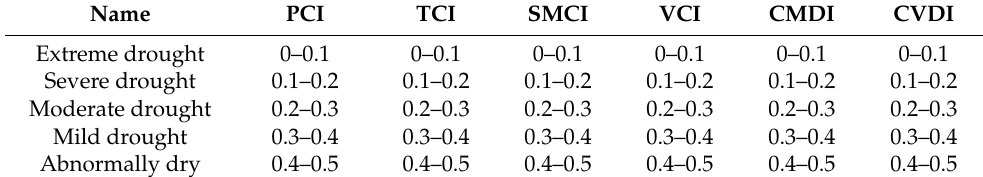
Table 3. Classification of drought severity for the CI-based drought indices used in this study.